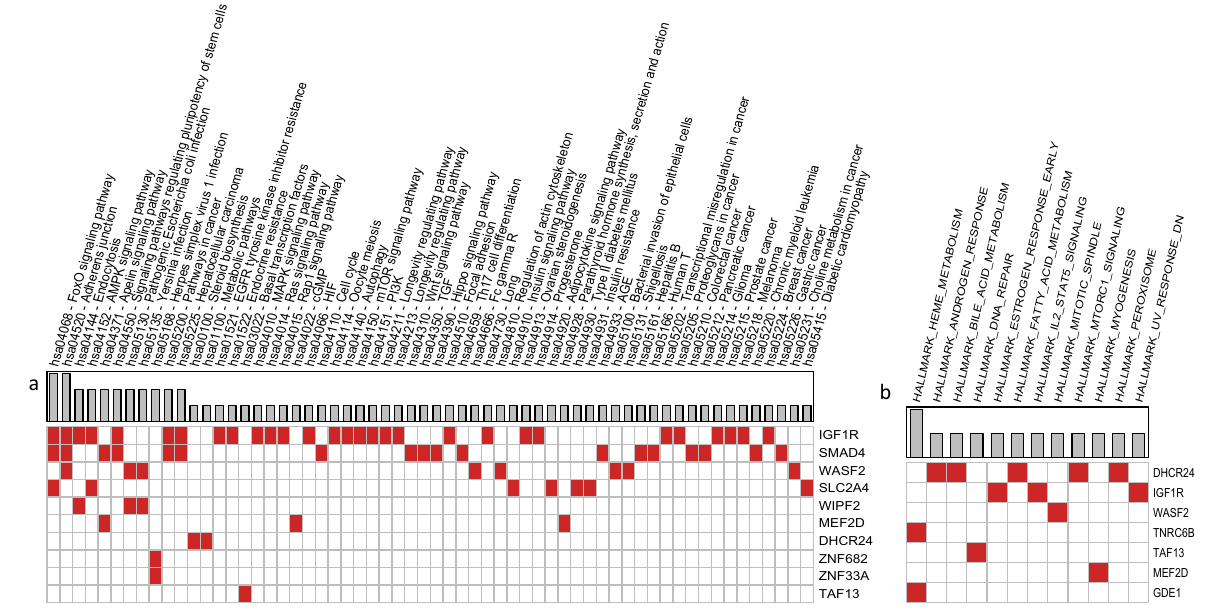
Figure 5. Functional annotation of miRNA and piRNA target genes from KEGG ( a ) and MSigDB- Hallmark ( b